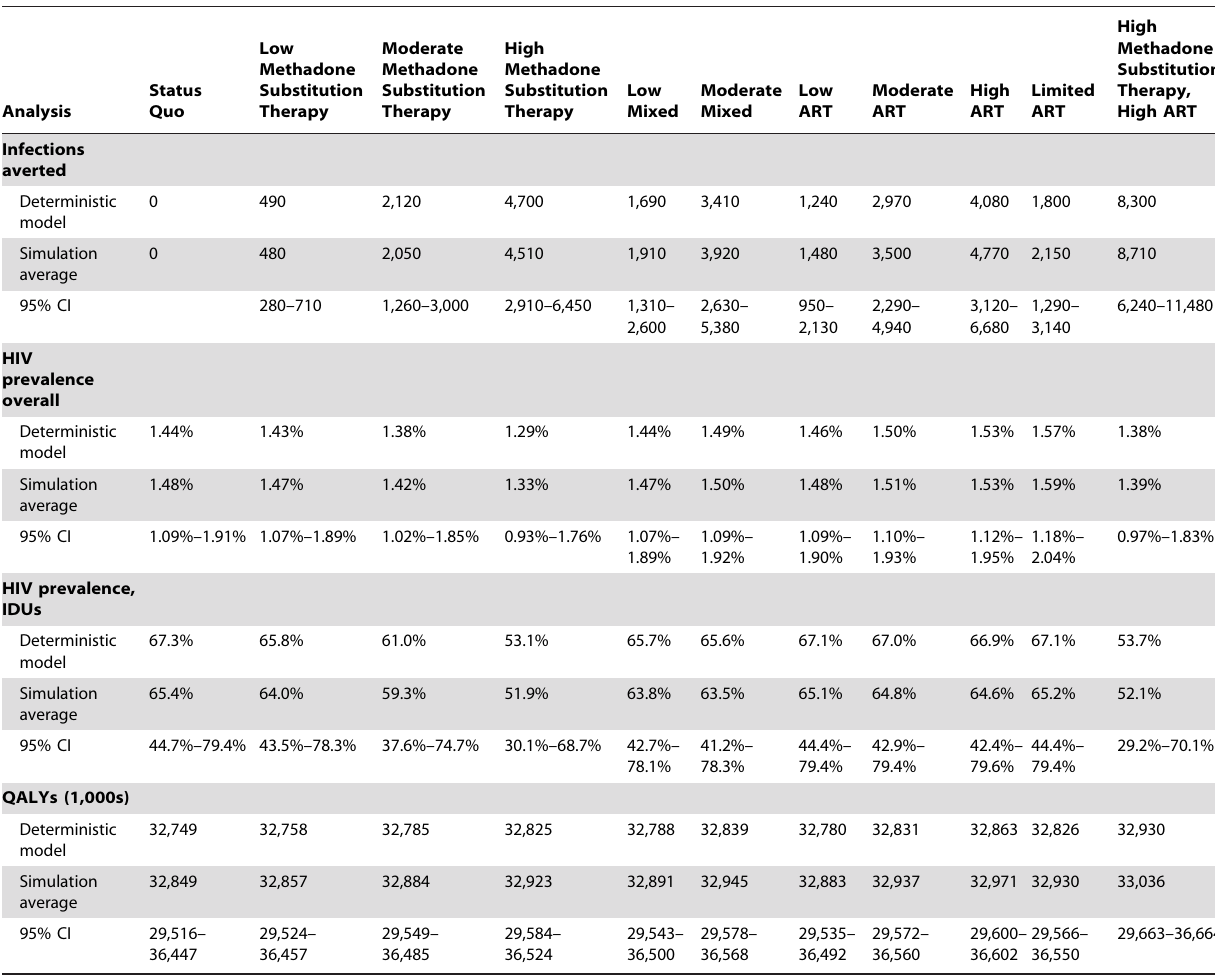
Table 6. Results of probabilistic sensitivity